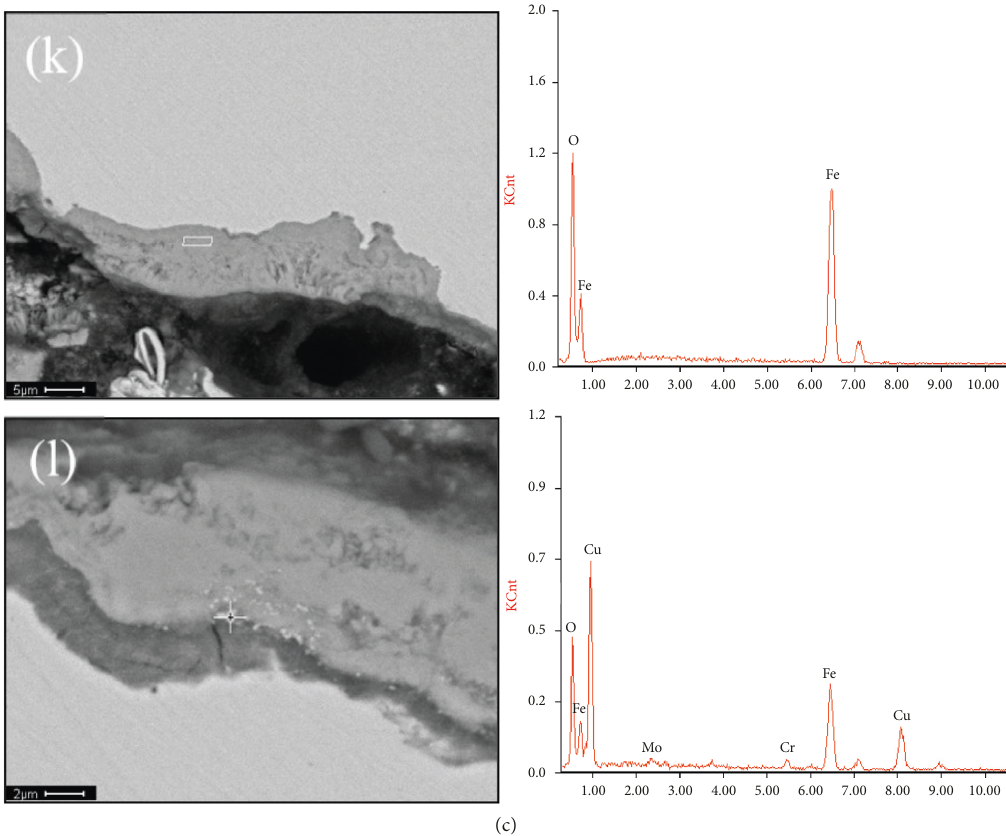
Figure 13: Scanning electron microscope analysis of X -3. (a) The X -3 crack. (b) Micromorphology of the crack surface. (c, h) Energy spectrum analysis. (d, e) Crack micromorphology. (f) Cleavage characteristic. (g, i) Local crack morphology. (j) Copper-rich particles. (k) Energy spectrum analysis of iron oxide. (l) Energy spectrum analysis of copper-rich